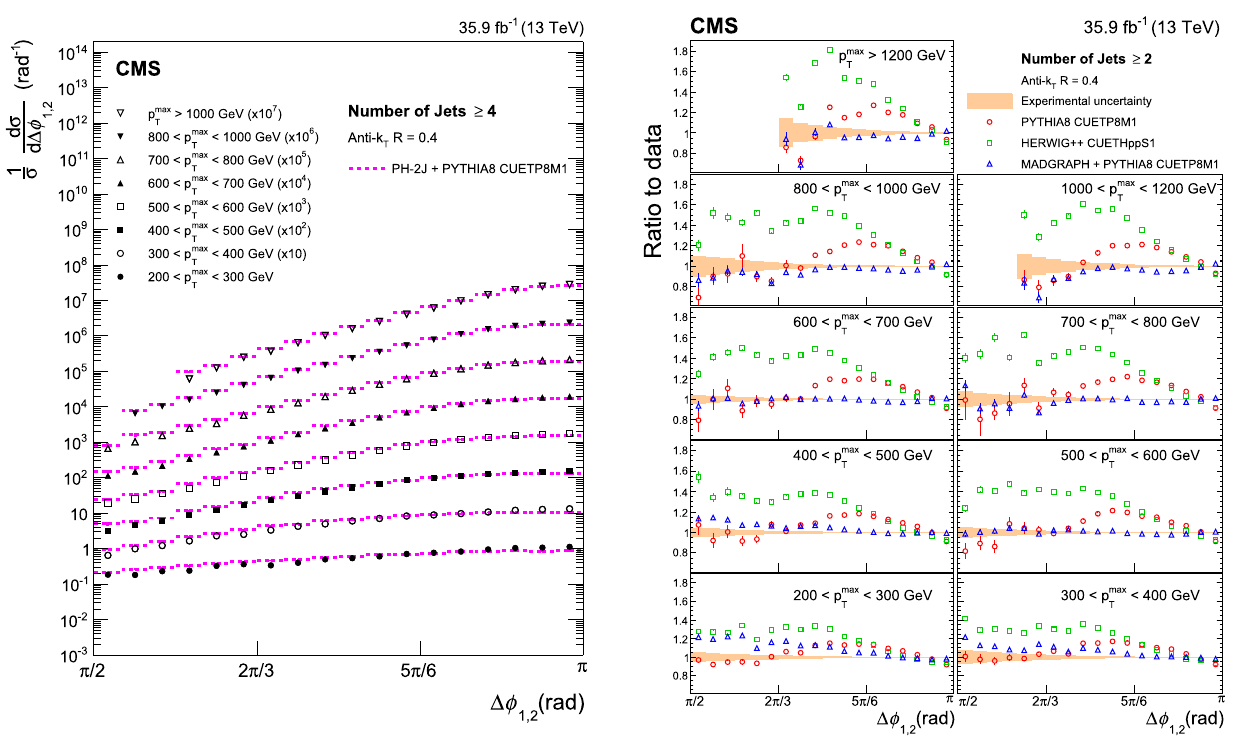
Fig. 4 Ratios of pythia 8, herwig++ , and MadGraph + pythia 8 predictions to the normalized inclusive 2-jet cross section differential in Δφ 1,2 , for all p max regions. The solid band indicates the total exper- T imental uncertainty and the vertical bars on the points represent the statistical uncertainties in the simulated